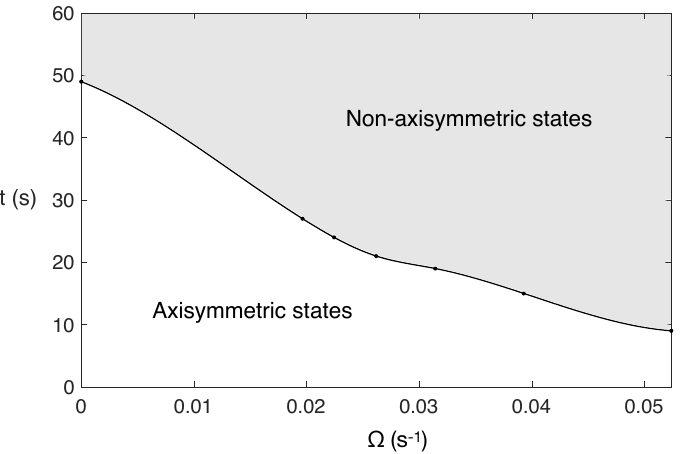
Figure 2. Diagram of the state-character varying the rotation rate Ω and t , for T e = 40 ◦ C. The shaded region corresponds to the zone where fully 3D states